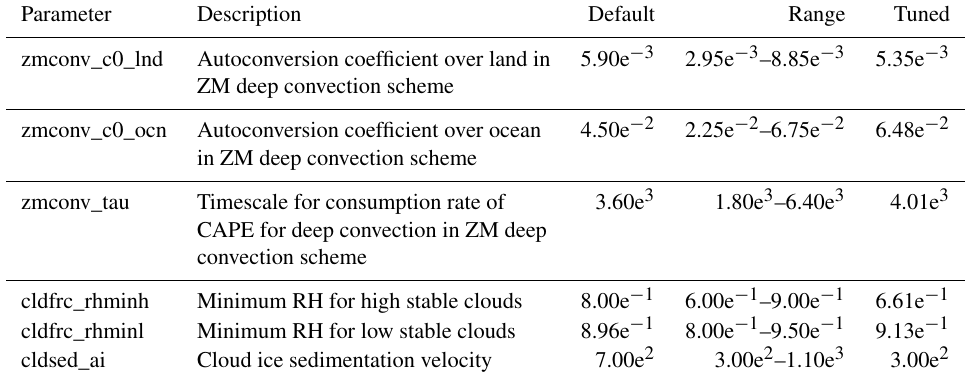
Table 1. A summary of parameters to be tuned in CAM5. The default and final tuned optimal values are shown, as well as the valid ranges of the corresponding parameters. ZM indicates the Zhang–McFarlane convection scheme. CAPE indicates convective available potential energy.